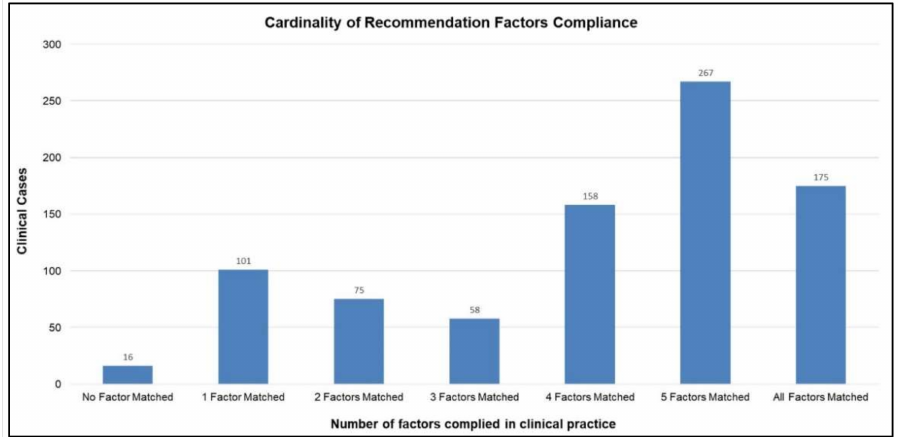
Figure 11. Cardinality of compliance among domain model and routine clinical practice for multi- factor